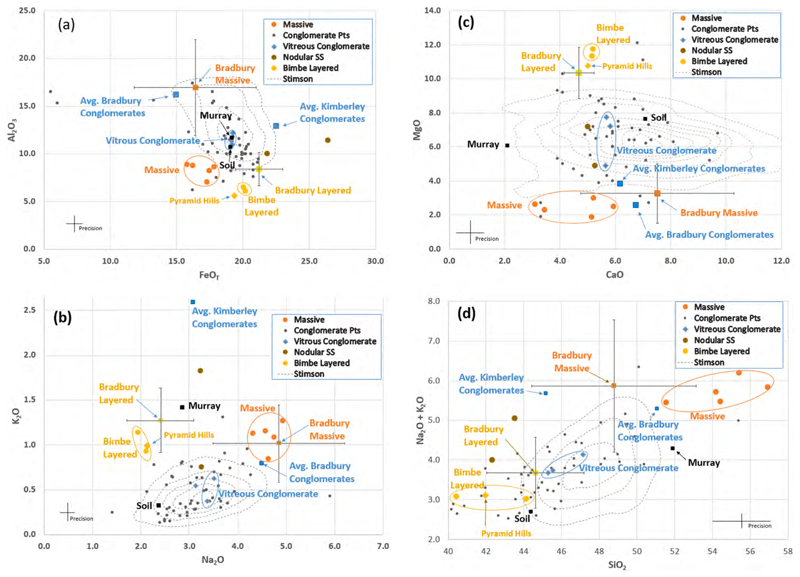
Major-element abundances, in wt%, of ChemCam targets at Bimbe. Larger symbols indicate averages of individual targets for Aussenkehr, Lucala, Seeis, Sonneblom, AEGIS_post_1406a (“Massive,” red dots); Wilhelmstal, Cabamba (“Vitreous Conglomerate,” blue diamonds, also includes AEGIS_post_1400a); Chinchimane, Oranjemund (“Bimbe Layered,” yellow dots), Auchab and Canico (“Nodular SS,” brown dots). Smaller symbols represent individual observation points for the conglomerates (“Conglomerate Pts”), which have more diverse compositions. Circles indicate groupings of Bimbe layered (yellow), massive (red), and vitreous conglomerate (blue) targets. Standard deviations between individual LIBS observation points within a target are given in Table 2. Upper limits on precision for individual point observations are shown in each panel, taken from 480 Sheepbed-formation measurements (Mangold et al., 2015). Also shown are the mean compositions, and standard deviations of the means, of other types of targets observed nearby and earlier along the traverse. These include Murray, Mars soil, two groups of conglomerates, ChemCam target Pyramid Hills, and a group of massive targets from Bradbury rise. Stimson-formation compositions are shown as contours where each contour represents equal weighting in terms of density of samples (see text and Supplementary material). (For interpretation of the references to color in this figure legend, the reader is referred to the web version of this article.)